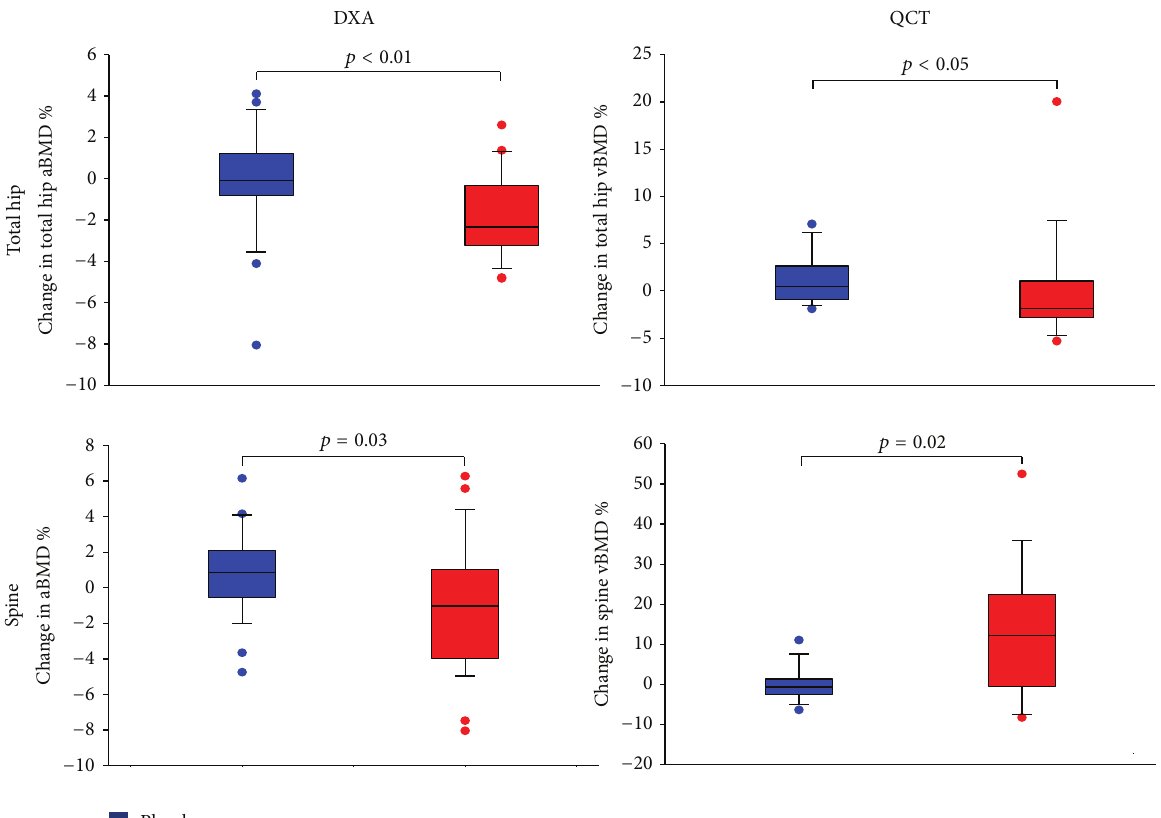
Figure 4: Changes in areal bone mineral density (aBMD) and volumetric bone mineral density (vBMD) as assessed by DXA and QCT scans, respectively. Changes were assessed between baseline and 24 weeks of trial during which studied patients were treated with 100 𝜇 g of PTH 1 (read) or placebo (blue)